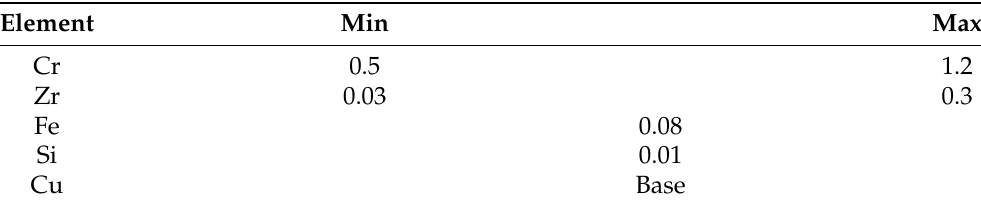
Table 1. Metal4Printing CuCrZr powder chemical analysis wt% (powder size 15–45 µm) [24].